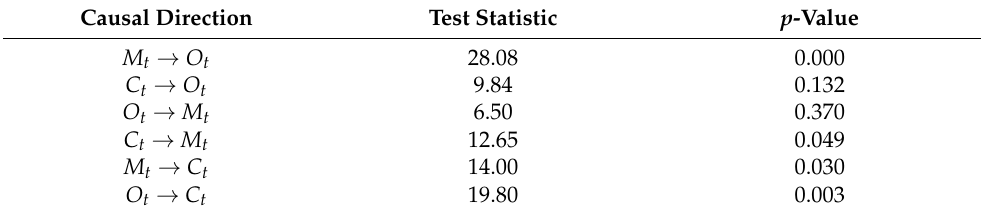
Table 4. Time domain Granger causality